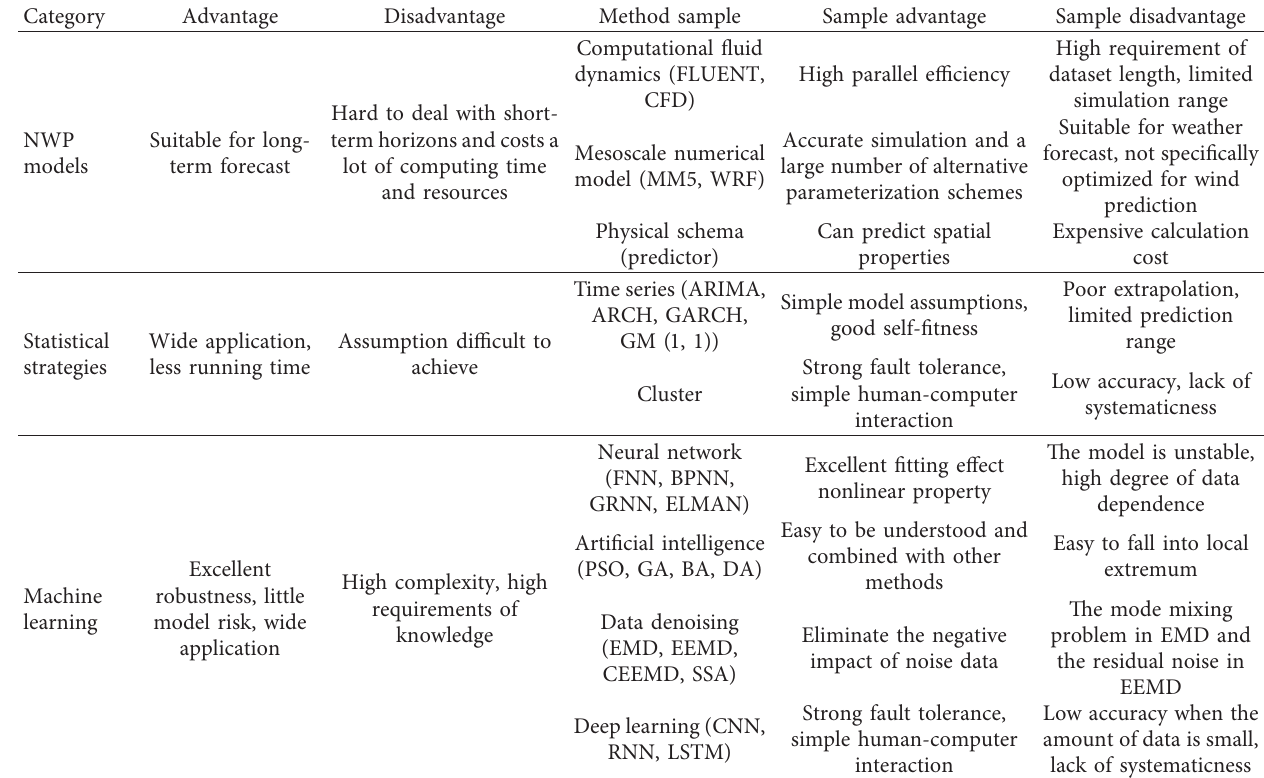
Table 1: Comparison on the advantages and disadvantages of existing wind speed forecasting methods.